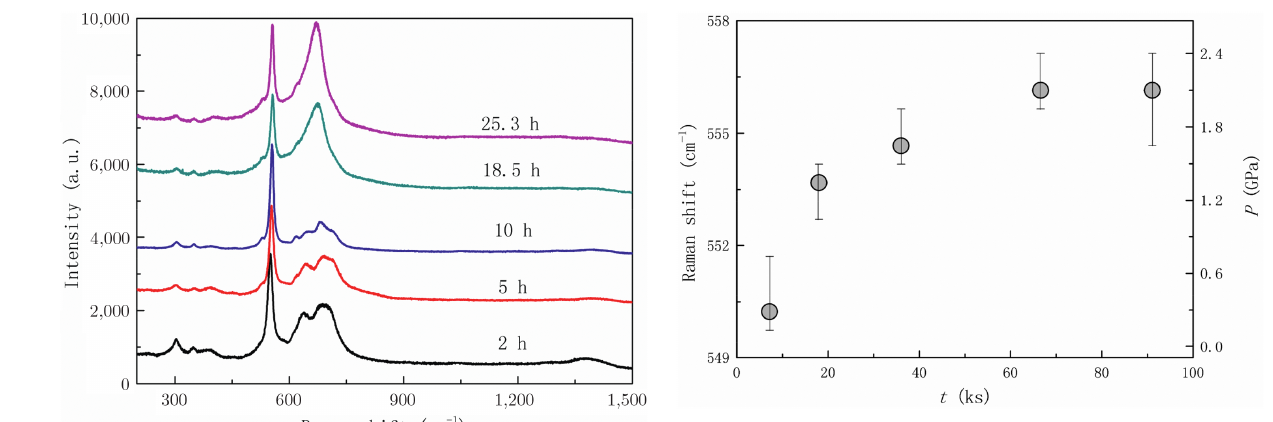
Figure 9: Raman band shift and growth stress of Cr 2 O 3 in the scales which developed on stainless steel 441 for different times at 1,000°C in air with 11.5 vol.% H 2